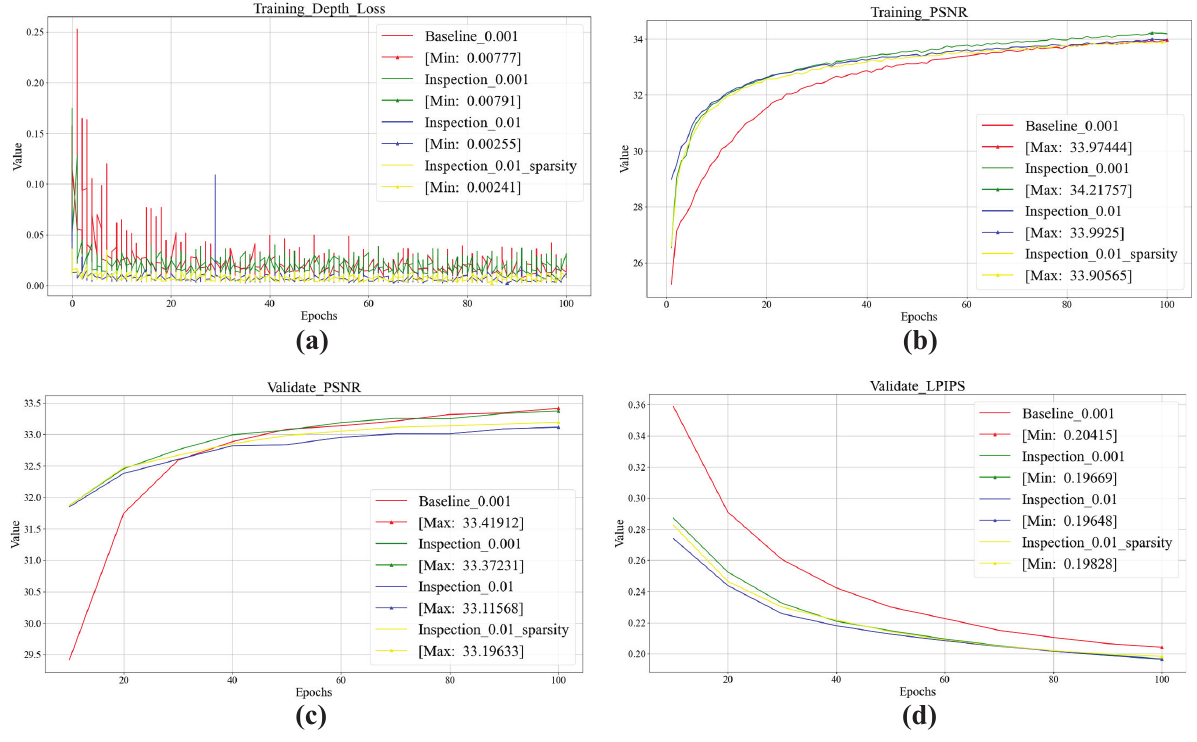
Figure 8. Training and validation results. ( a , b ) depict changes in depth loss and average PSNR during training, respectively. ( c , d ) depict the averaged PSNR and LPIPS metrics during validation